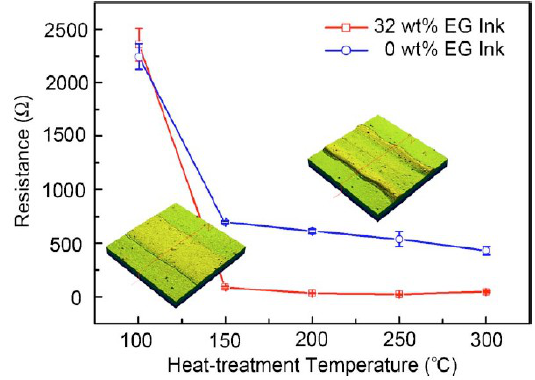
Figure 5. Decreasing the resistance of ink-jet printed Ag NPs thin film by increasing the sintering temperature (0 and 32 wt.% ethylene glycol as carrier solution). Reproduced with permission from [14]. Copyright 2006 AIP Publishing.